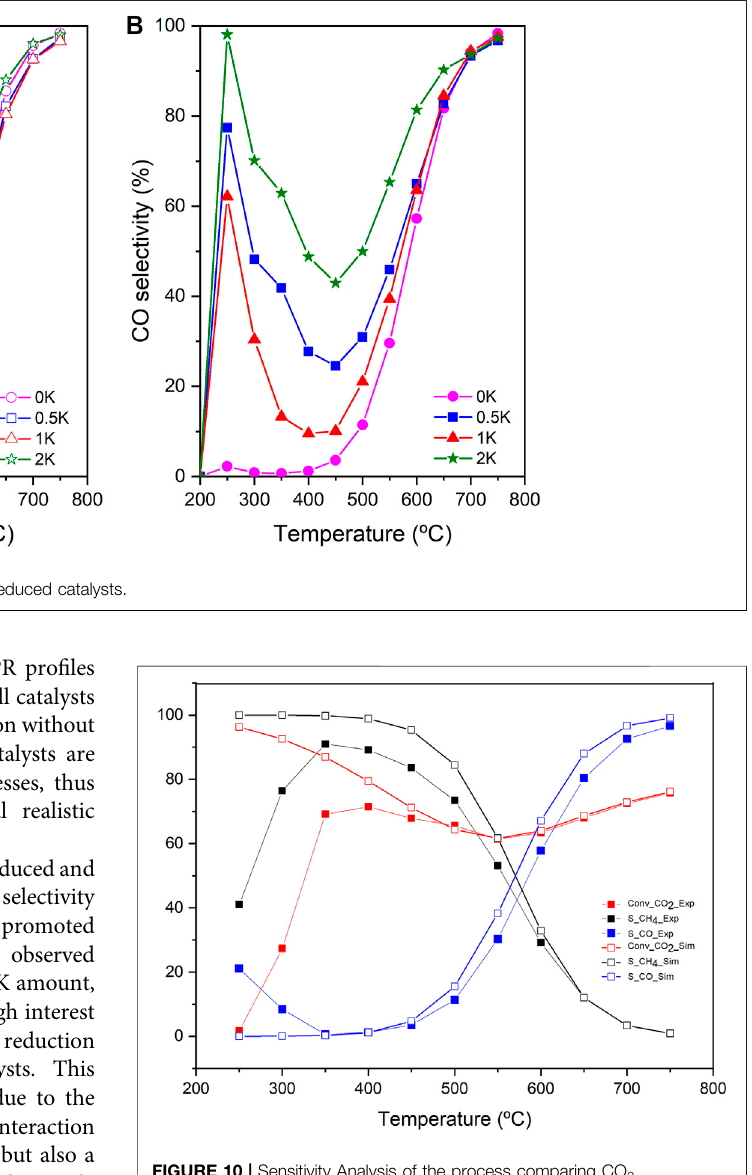
FIGURE 10 | Sensitivity Analysis of the process comparing CO 2 conversion, CH 4 selectivity and CO selectivity from the present model and experimental